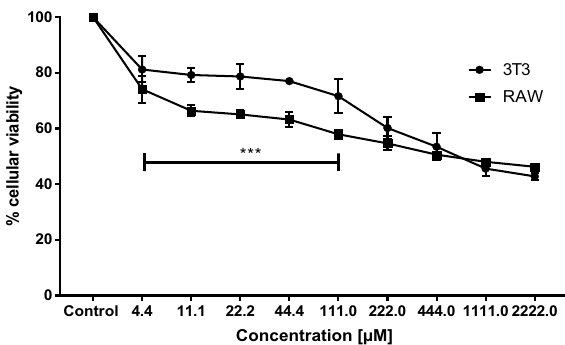
Figure 3. Evaluation of the MTT reduction in 3T3 and RAW cell lines exposed to diethyldithiocarbamate. Viability curves of the 3T3 and RAW cell lines obtained through the MTT reduction assay when treated with different concentrations of DETC for 24 h. 100% of MTT reduction represents cells untreated. The curves present in this image were constructed based on mean ± standard deviation of the percentage of MTT reduction for each cell line (RAW and 3T3). To compare the MTT metabolization of each cell lines against same concentration of DETC treatment, a statistical analysis was performed using T de student Test. The statistical analysis showed difference in metabolization on range concentrations from 11.1 to 44.4 µM P < 0.001 (***). Software GraphPad Prism v. 7.0 (2016) (https:// www. graph pad. com/).